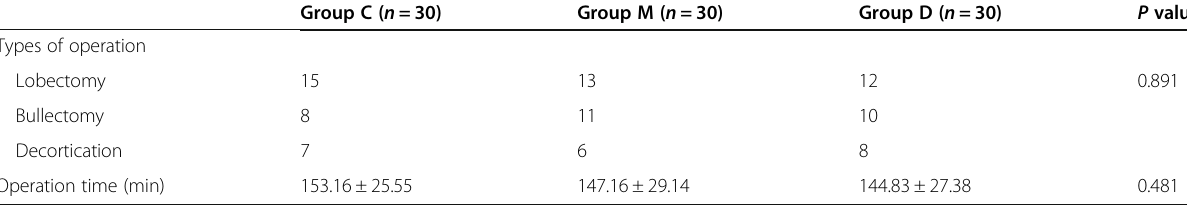
Table 4 Procedure-related variables of the study groups expressed as mean ± SD or number of patients